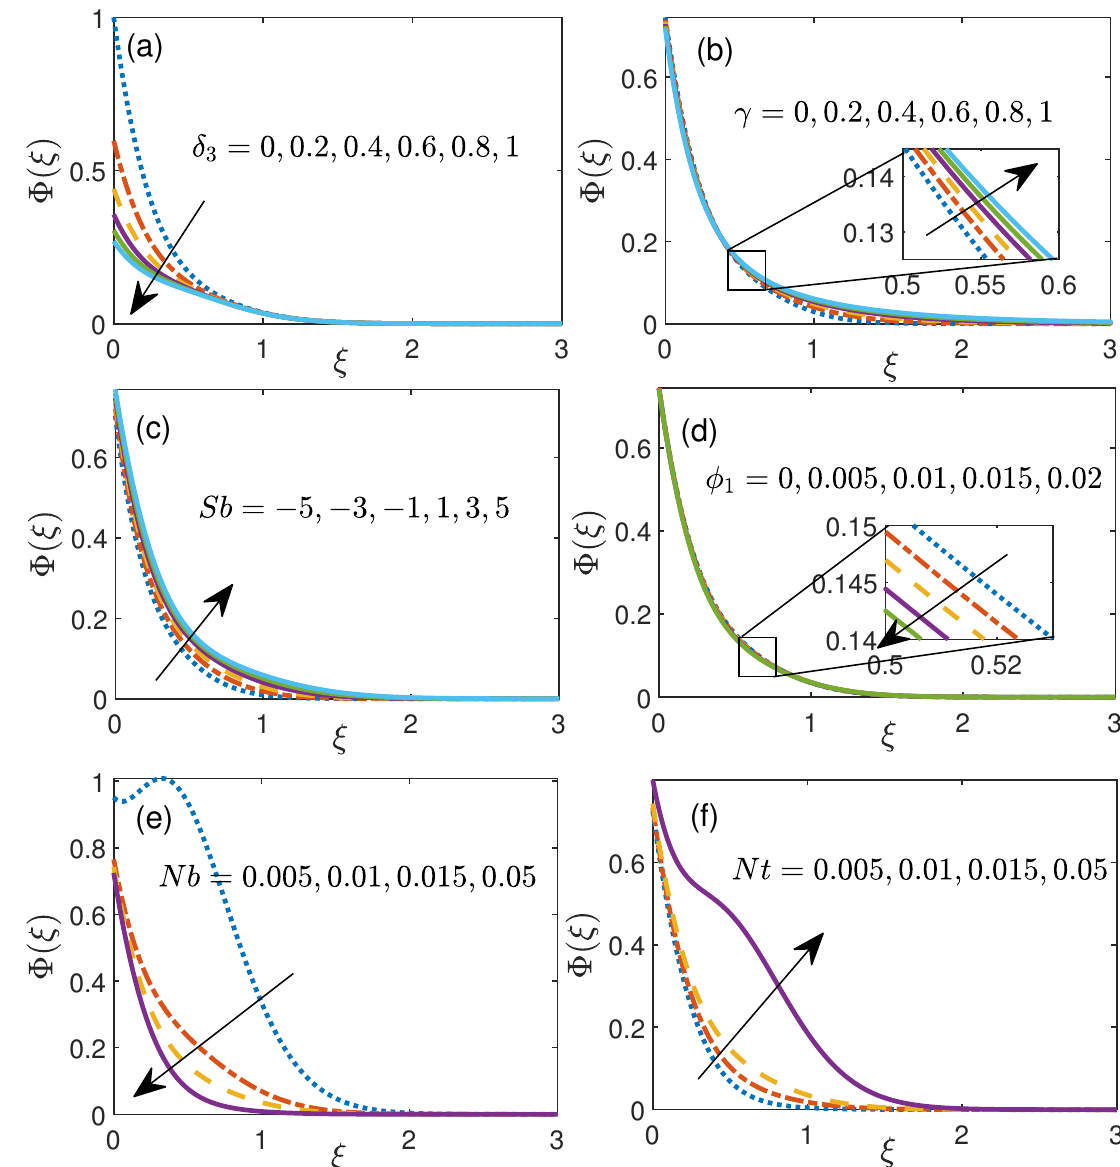
Figure 5. Volume fraction profile for ( a ) slip parameter δ 3 , ( b ) curvature parameter γ , ( c ) Stefan blowing Sb , ( d ) initial volume fraction φ 1 , ( e ) Brownian motion Nb , ( f ) thermophoresis Nt